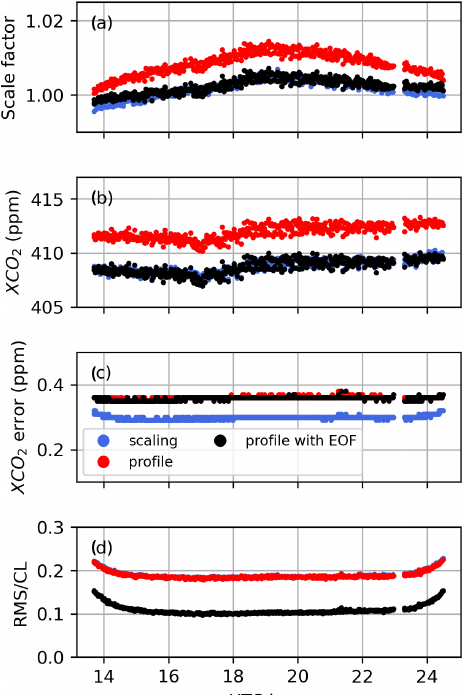
Figure E5. Same as Fig. E2 but for the Weak1 window.